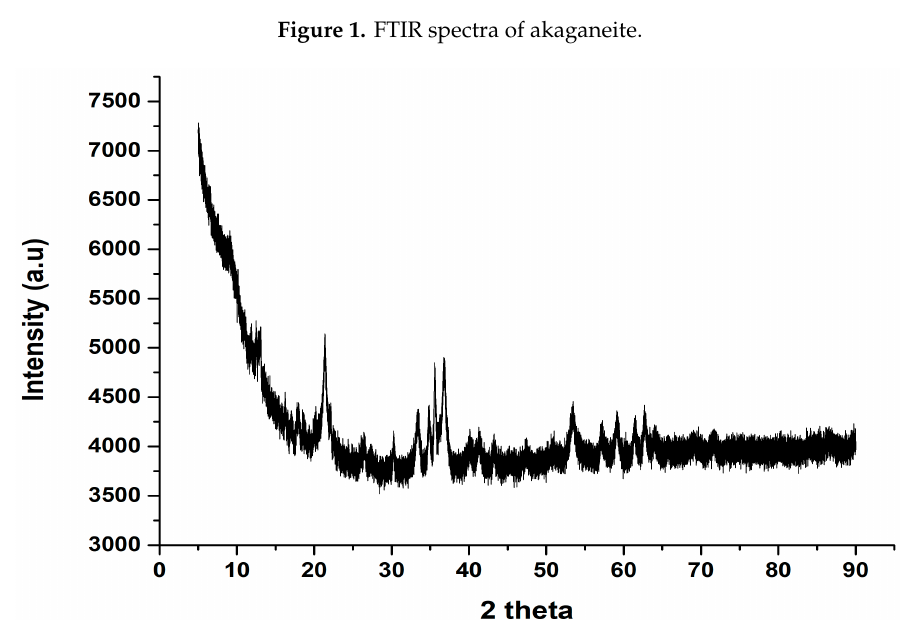
Figure 1. FTIR spectra of akaganeite.